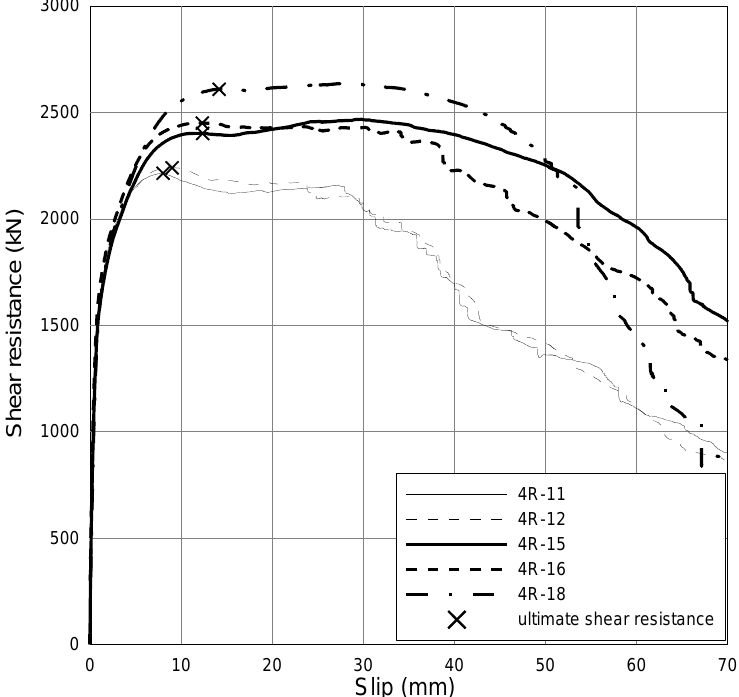
Figure 3. Load-slip curves of Y-type perfobond rib shear connectors (this study). Equation (1) is designed to represent 3 main contributions, that is, the first term is for the end-bearing resistance, the second term is for the resistance by the transverse rebars, and the third term is for the resistance by Y-ribs. Because the first term provides the end bearing resistance due to the first one pair of Y-ribs located at the fronts of multi-ribs in the direction of slip, the third term contains “ − 2” to reduce the total number of Y-ribs. The end bearing effect may not be significant as the total number of Y-ribs increases, and it can be included in the third term. In addition, the current formula does not consider the influences of steel grades of a Y-rib and transverse rebar. Figure 4 shows the estimation errors of Equation (1) compared to the experimental results for 2-rib, 4-rib, and 6-rib specimens. The experimental results from 2-rib specimens are found to be overestimated by the current resistance formula. It is due to the non- symmetric and unstable shape effect of only one rib in each side of Y-type shear connectors. This effect can be reduced with the increasing number of ribs. The statistical characteristics